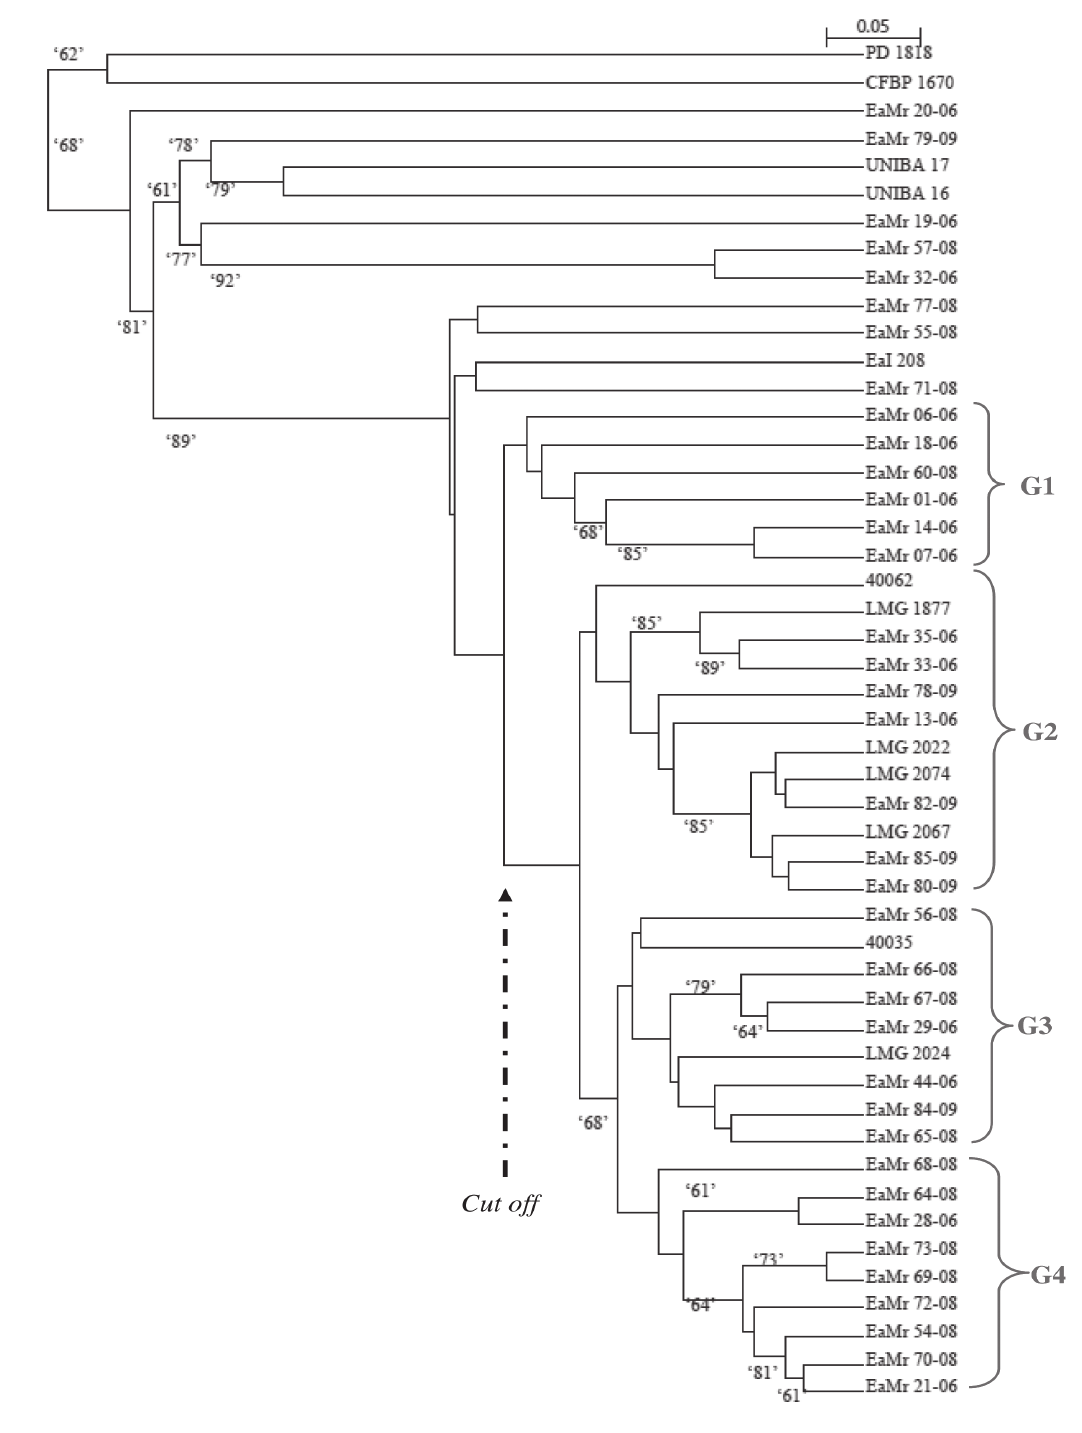
Figure 6. Dendrogram of Erwinia amylovora strains derived from fAFLP analysis calculated with unweighted pair- group method with average linkages (UPGMA) using the Jaccard’s coef fi cient. Clusters (18.4% cut off) are indicated with letters: G1, G2, G3, G4, and the robustness of the tree was assessed by bootstrap